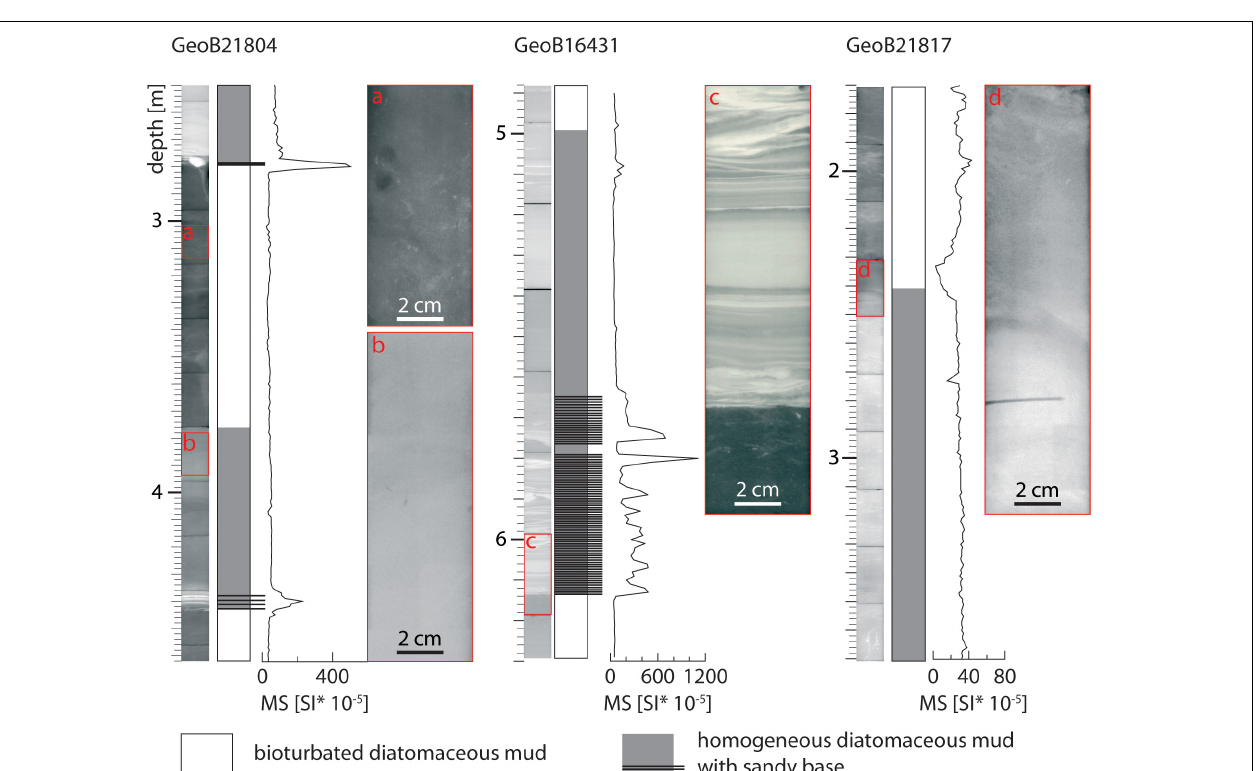
Frontiers in Earth Science |